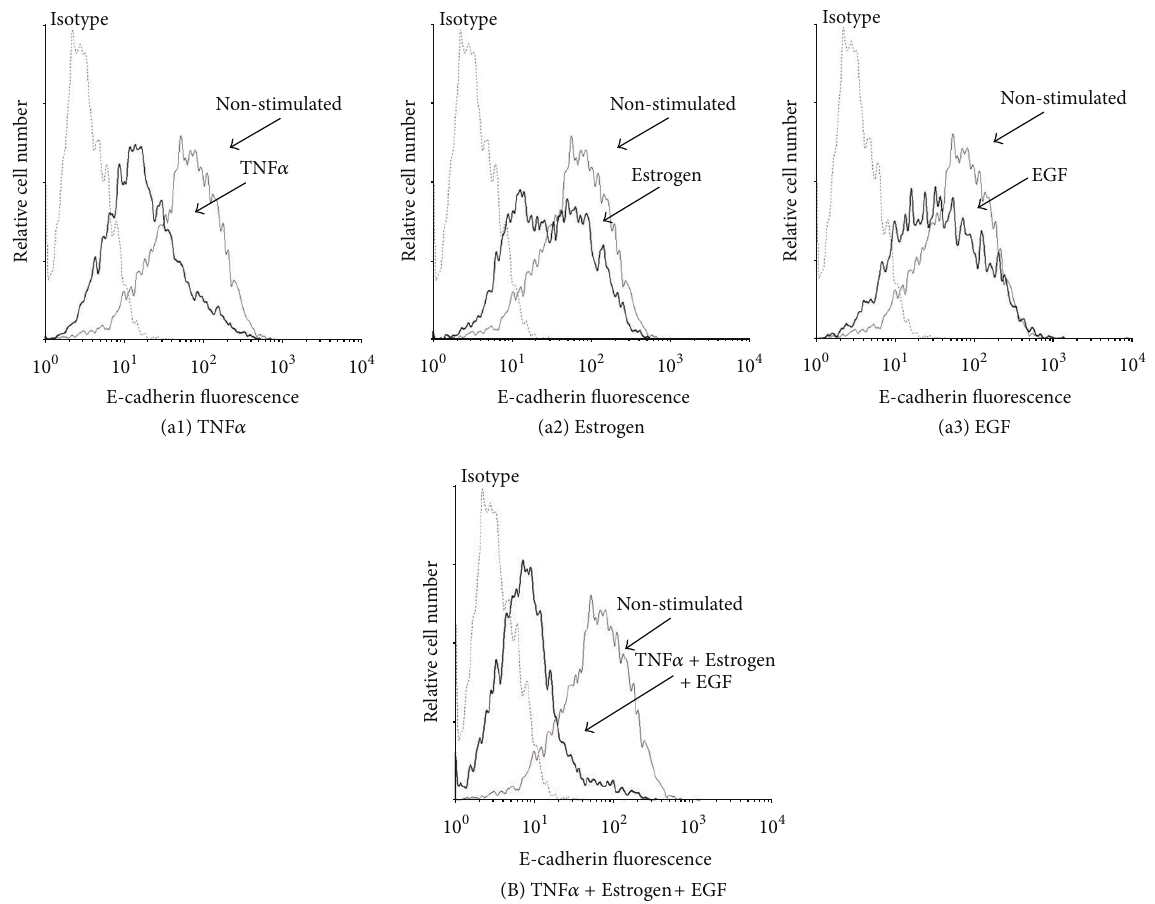
Figure 6: Combined stimulation by TNF 𝛼 + Estrogen + EGF leads to potent downregulation of E-cadherin expression by breast tumor cells. ((a), (B)) Determination of E-cadherin expression. Breast tumor cells were stimulated by (a1) TNF 𝛼 , (a2) estrogen, (a3) EGF, or (B) TNF 𝛼 + Estrogen + EGF (concentrations as in Figure 1) for three days. Non-stimulated: cells grown with the diluents of the above factors.